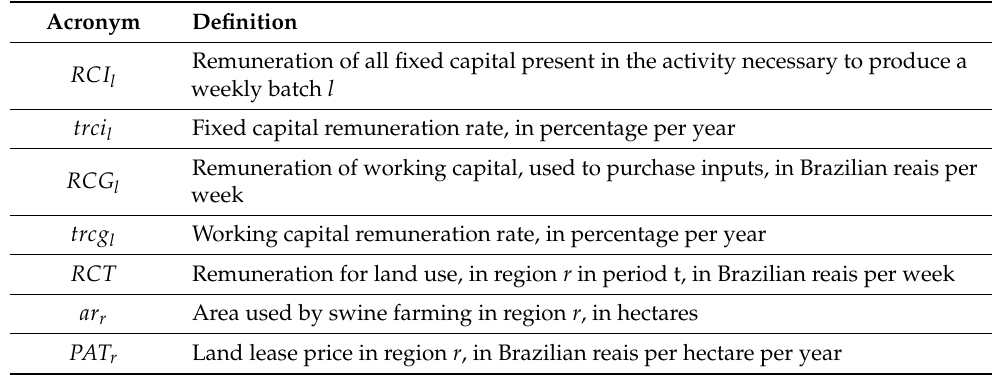
Table 7. Acronyms and definitions of formulas used to calculate the opportunity costs of capital and land that compose the calculation model for swine